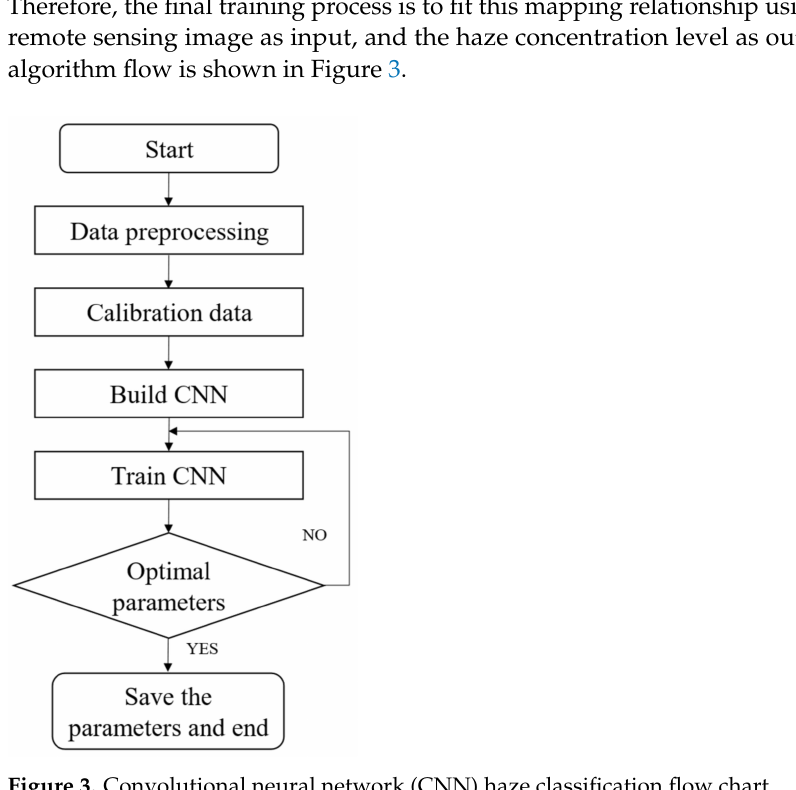
Figure 3. Convolutional neural network (CNN) haze classification flow